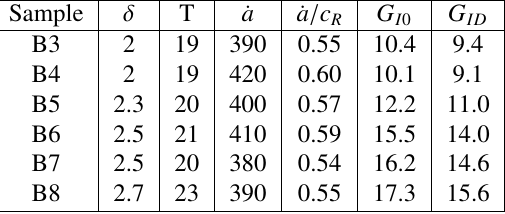
Table 1. Estimation of the fracture energy G ID (kJm − 2 ), the quasi-static energy release rate G I 0